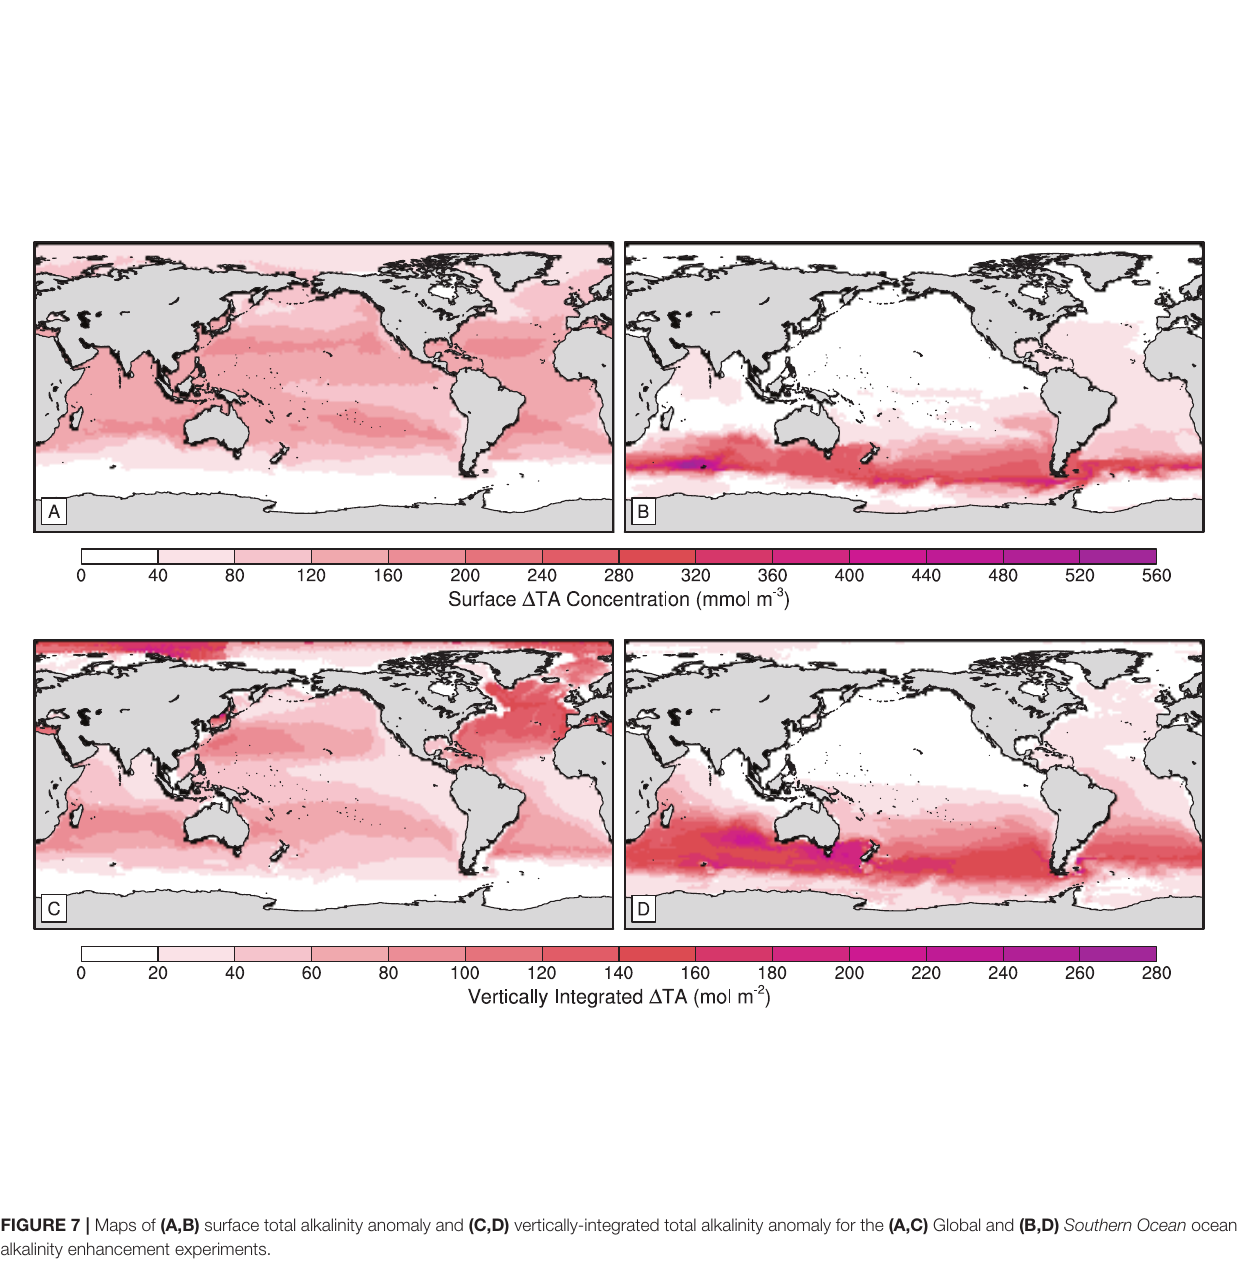
FIGURE 7 | Maps of (A,B) surface total alkalinity anomaly and (C,D) vertically-integrated total alkalinity anomaly for the (A,C) Global and (B,D) Southern Ocean ocean alkalinity enhancement experiments.